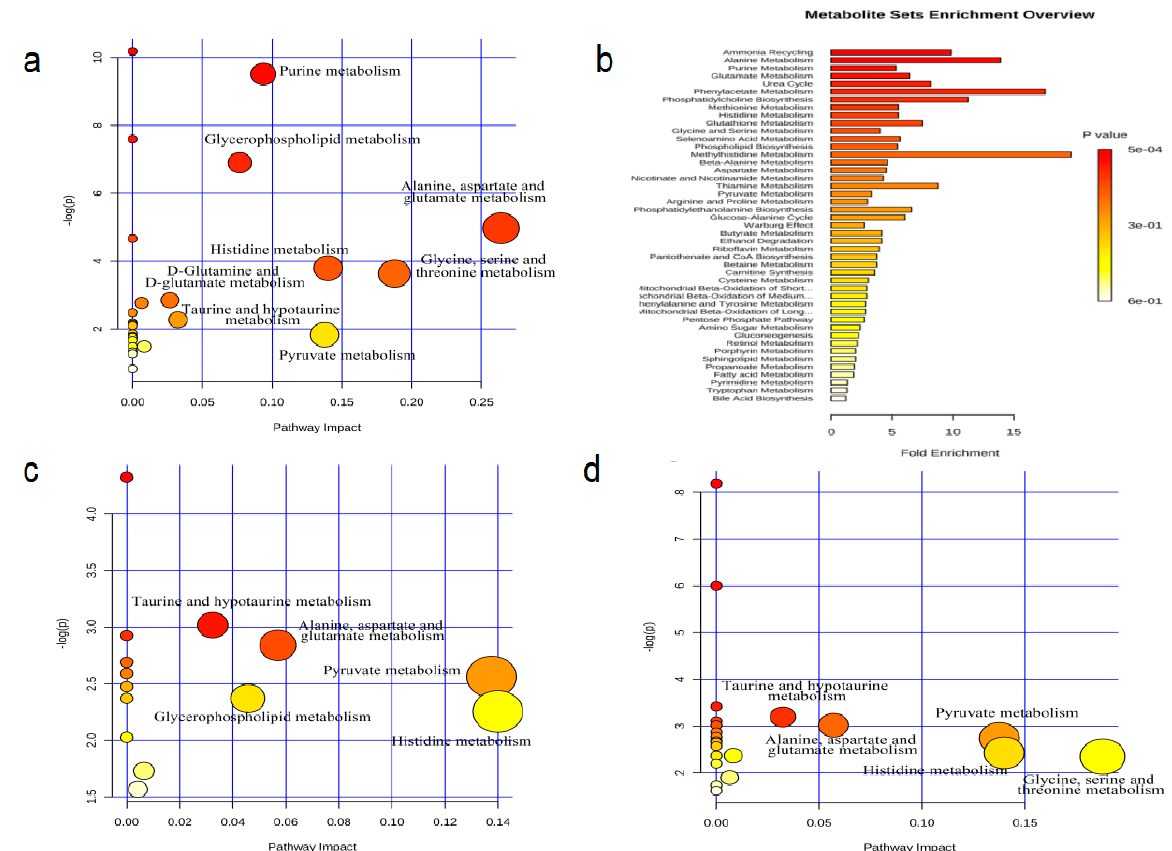
Figure 7. MetPA analysis of metabolic pathway (( a ) C vs. D; ( c ) D vs. E; ( d ) D vs. R) and enrichment of metabolite sets in rat soleus muscle ( b ).